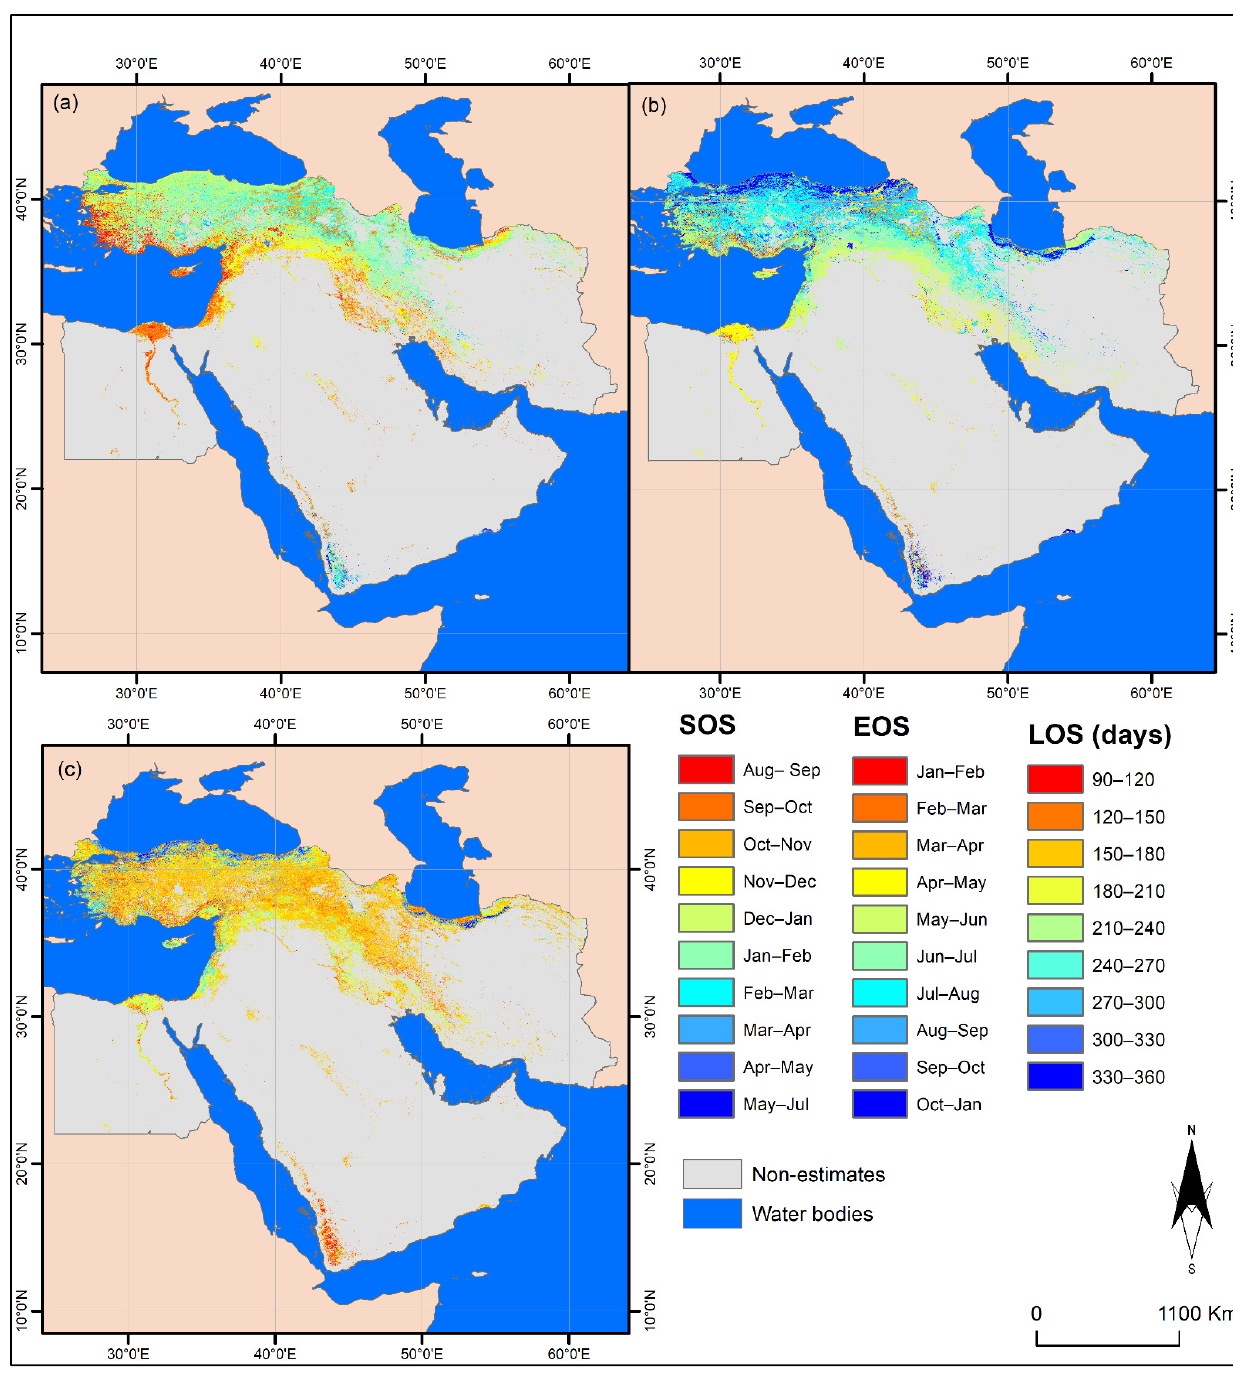
Figure 4. The median values of phenological patterns derived from Landsat data from 2000 to 2020, ( a ) start of the season (SOS), ( b ) end of the season, and ( c ) length of the season. The EOS dates range from 13 (January) to 24 (December) and their spatial variation is smaller than SOS (Figure 4b). This might be due to a lack of moisture and facing a hot summer across the region. The earlier SOS is generally a coincidence with an earlier EOS and vice versa. Areas with a later EOS exhibit a longer growing season than areas with an earlier SOS (Figure 4b). However, this might not be applicable to the majority of Grassland